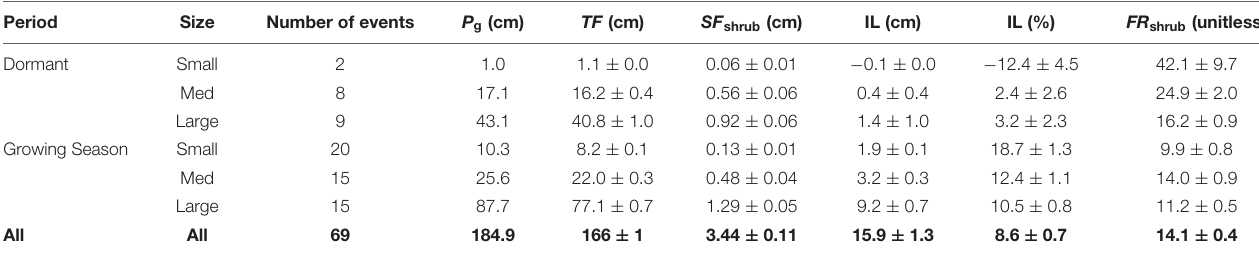
TABLE 2 | Cumulative depth of gross precipitation ( P g ), throughfall ( TF ), shrub stemflow ( SF shrub ), and shrub SF funneling ratio ( FR shrub ), and interception loss (IL) over the 15-months-measuring period, stratified by event size (small < 1 cm, 1 cm ≤ medium < 3 cm, and large ≥ 3 cm) and season (dormant versus growing seasons). Period Size Number of events P g (cm) TF (cm) SF shrub (cm) IL (cm) IL (%) FR shrub (unitless)